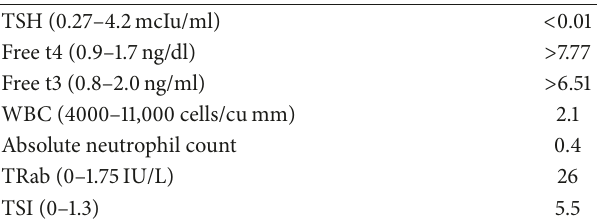
Table 1: Laboratory assessment on